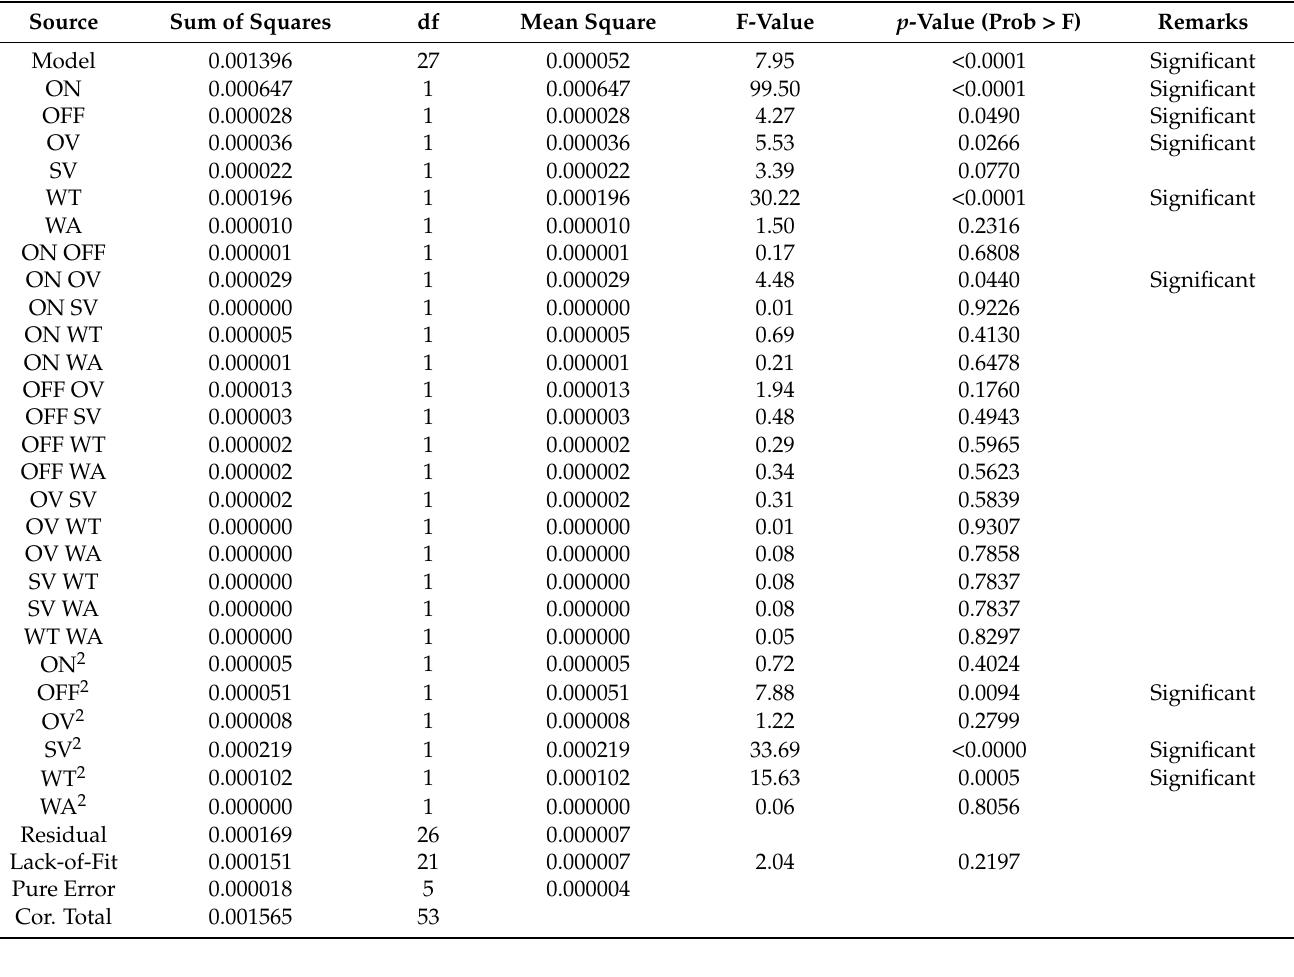
Table 4. ANOVA results of quadratic response surface model for 60 ◦ corner.